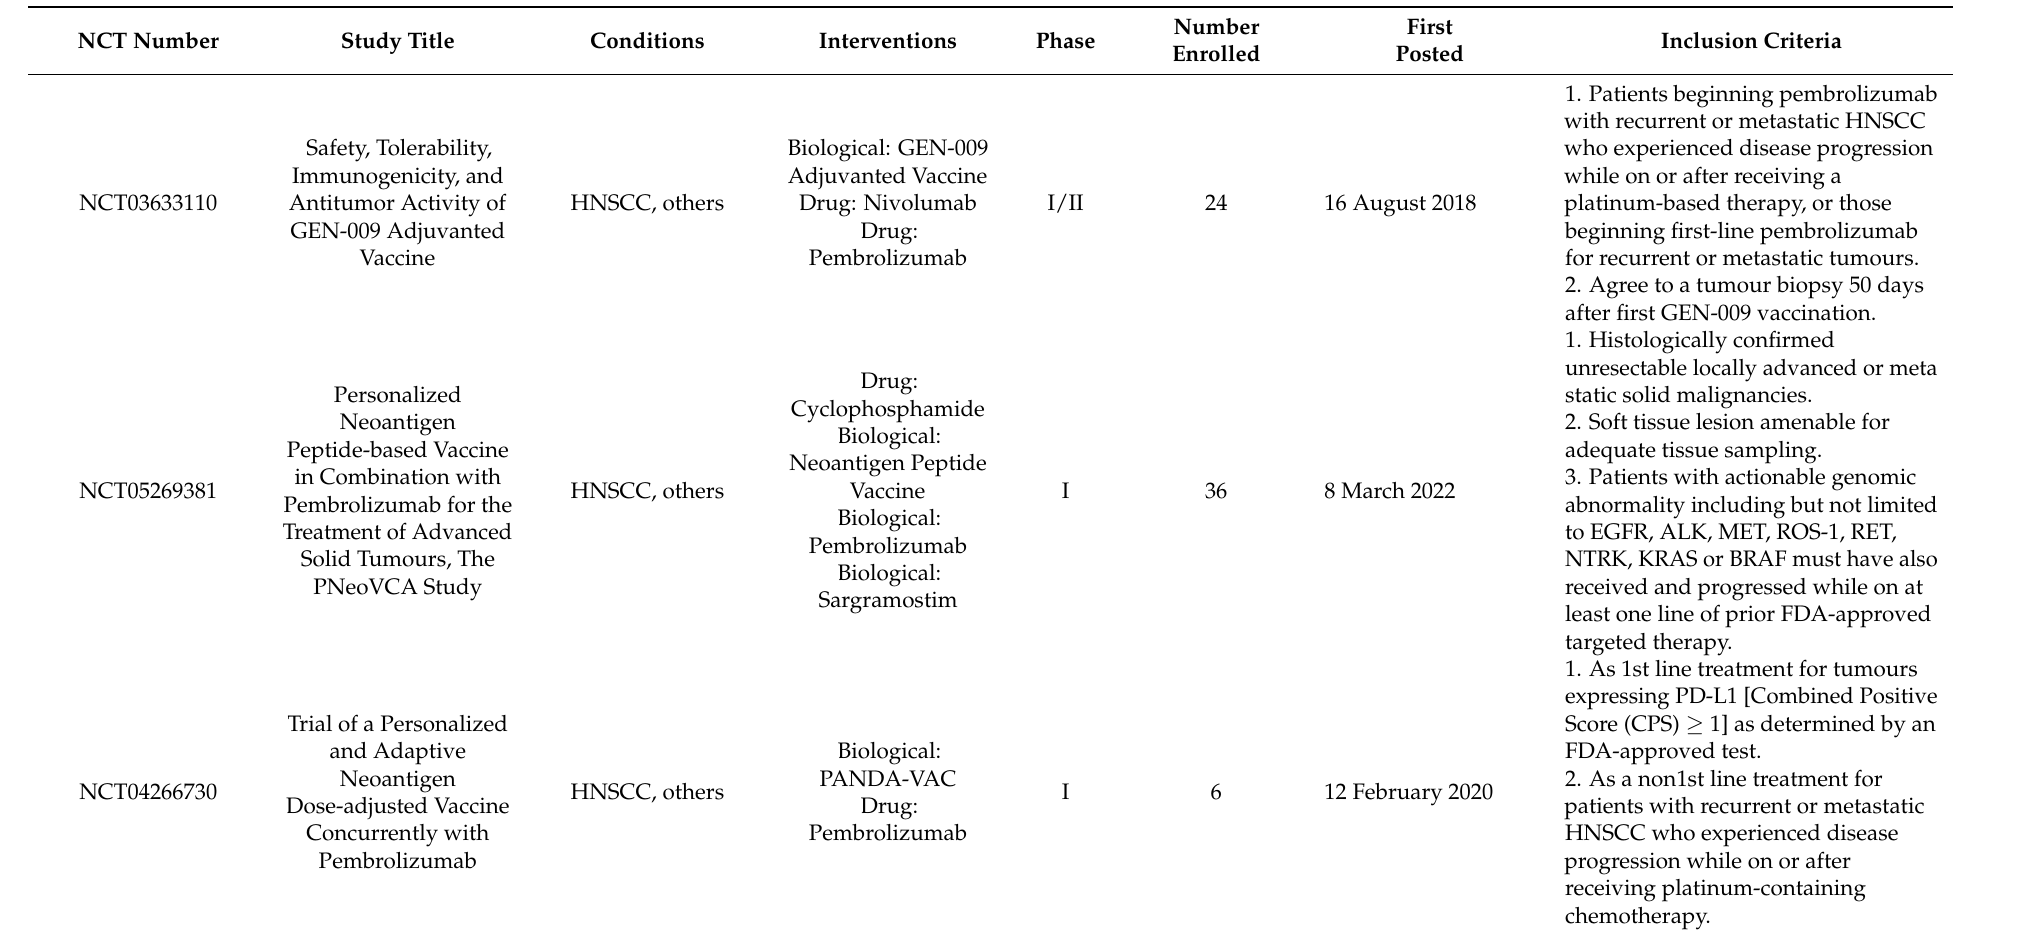
Table 1. Clinical trials of neoantigen vaccines for